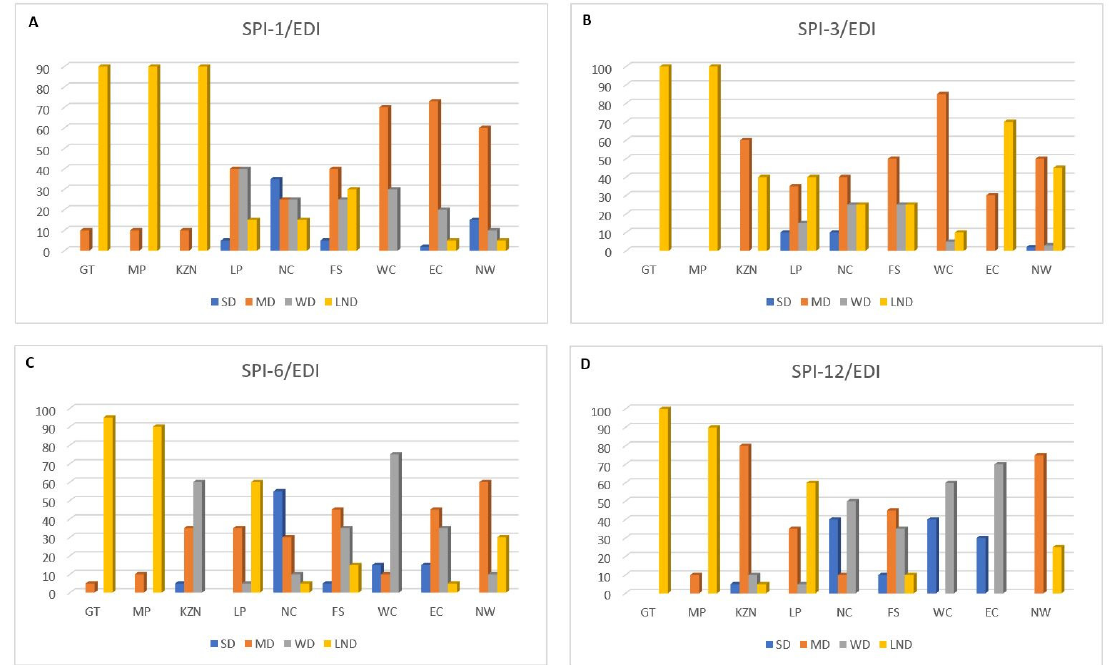
Figure 4. Percentage of Pearson’s correlation coefficient estimate dissimilarity measure for drought duration in South Africa. ( A ) SPI-1/EDI; ( B ) SPI-3/EDI; ( C ) SPI-6/EDI; and ( D ) SPI-12/EDI. Strong Dissimilarity (SD), Moderate Dissimilarity (MD), Weak Dissimilarity (WD), Little or No Dissimilarity